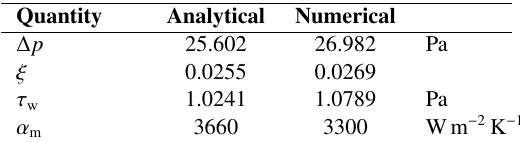
Table 4. A comparison between the results based on numerical simulations and the analytical results based on engineering correlations. The pressure drop can be expressed from the Darcy-Weisbach equation ∆ p = ξ · L / d · (cid:37) ¯ u 2 / 2, and the wall shear stress from τ w = ∆ pd / 4 L .